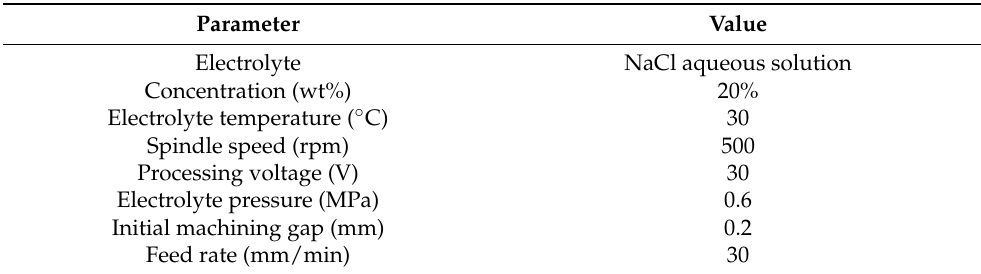
Table 3. Main parameters of groove-machining experiment.